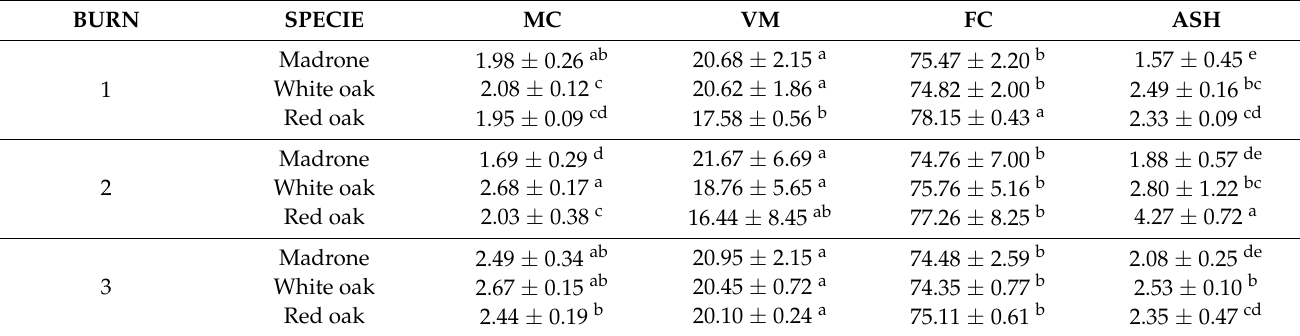
Table 7. Proximate analysis of charcoal produced in Brazilian beehive kilns.